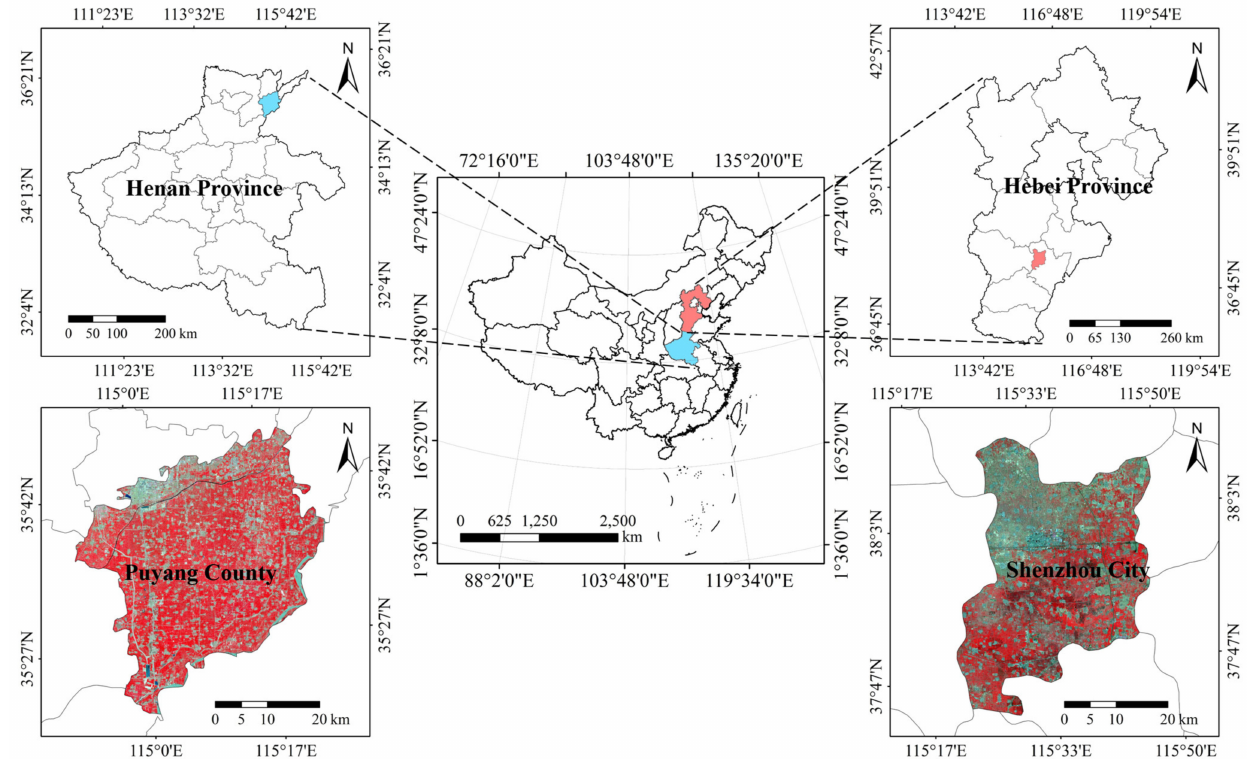
Figure 1. Location of Puyang County, Henan Province and Shenzhou, Hebei Province,